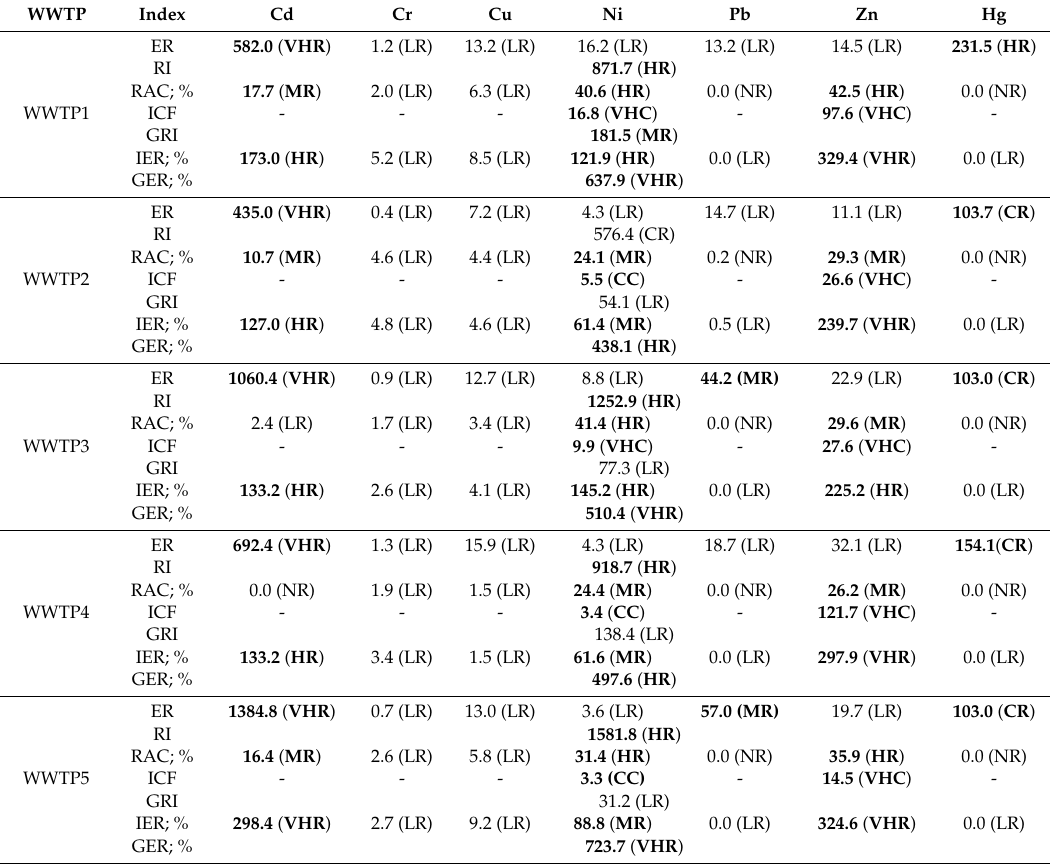
Table 7. Ecological risks of the heavy metals in the thickened sewage sludge